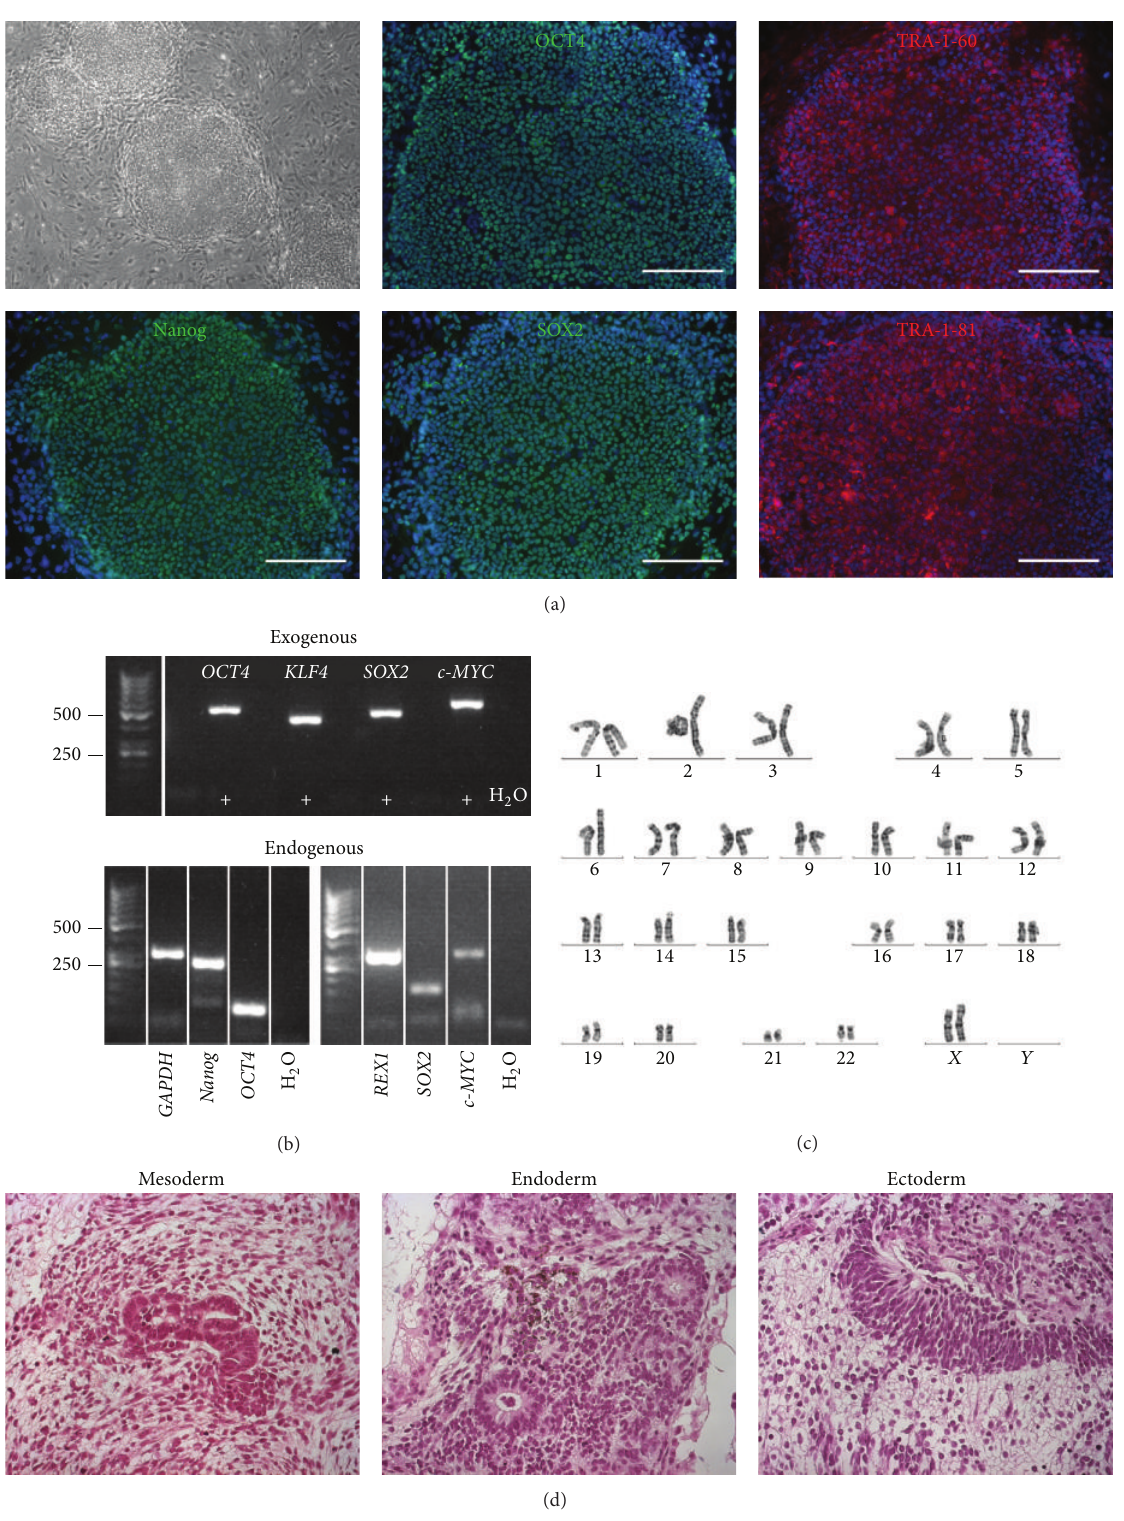
Figure 1: Characterization of UTA.13602.HCMT cell line. (a) The hiPSCs formed colonies expressing Nanog, OCT4, SOX2, TRA-1-60, and TRA-1-81.Scalebars:200 𝜇 m.(b)ThevirallytransferredSendaiexogenes, exo-OCT4 (483bp), exo-KLF4 (410bp), exo-SOX2 (451bp),and exo- c-MYC (532 bp), were silenced in the hiPSCs. + indicates positive controls, for which RNA was extracted from cells 1 week after transduction. hiPSCs expressed endogenous Nanog (287 bp), OCT4 (144bp), REX1 (306 bp), SOX2 (151bp), and c-MYC (328 bp). GAPDH (302 bp) was used as a housekeeping control. (c) The hiPSC line was karyotypically normal, 46 XX. (d) The pluripotency of hiPSCs was confirmed by in vivo teratoma assay, in which hiPSCs formed all three germ layers (mesoderm, endoderm, and